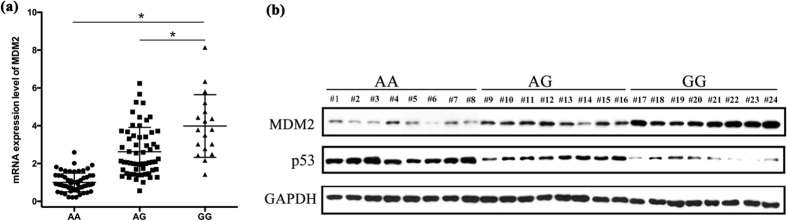
Association between rs937283 polymorphism and MDM2, p53 expression.(a) MDM2 transcript in RB tumor tissues from individuals with different rs937283 genotypes was detected by qRT-PCR; Circle, RB patients with AA genotype; Square, RB patients with AG genotype; Triangle, RB patients with GG genotype; *P < 0.05. (b) MDM2 and p53 protein levels were evaluated by western blotting; #1 to #8, RB patients with AA genotype (n = 8); #9 to #16, RB patients with AG genotype(n = 8); #17 to #24, RB patients with GG genotype(n = 8). (MDM2, 90 kd; p53, 53 kd; GAPDH, 37 kd) The densitometric analysis of western blotting was shown in Supplementary Fig. S2.